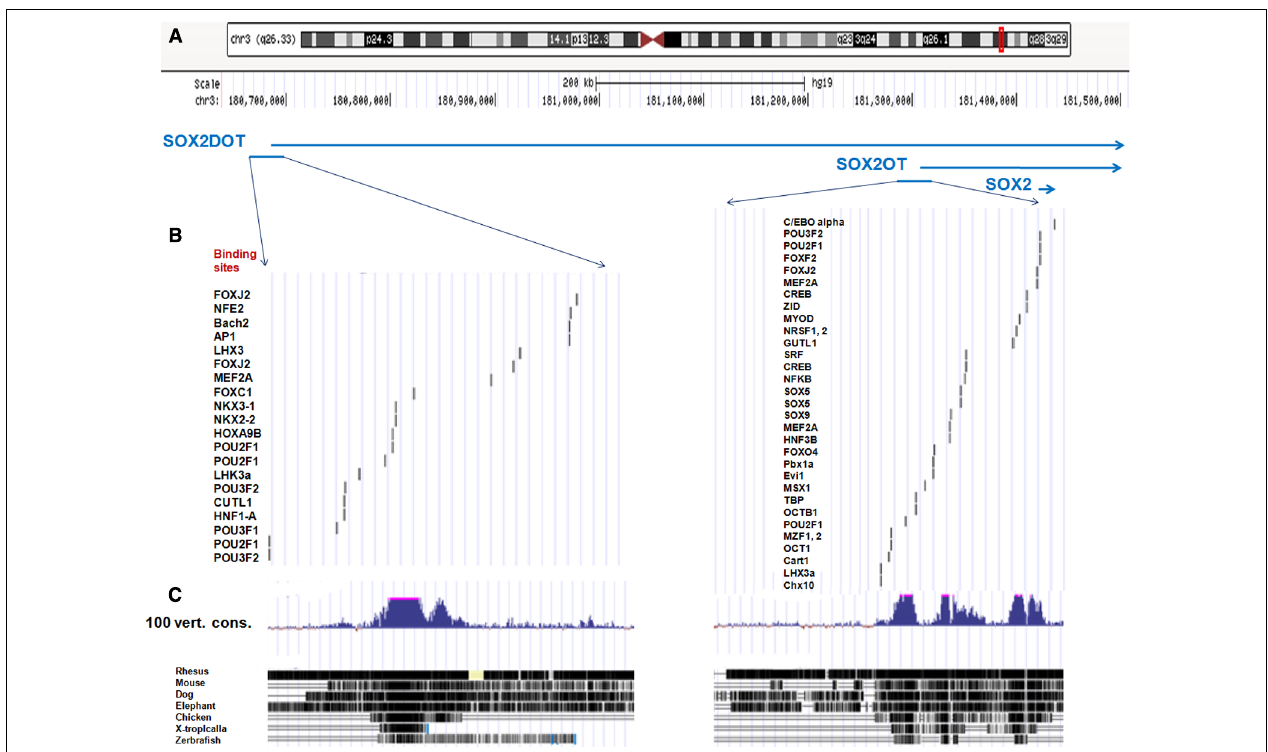
FIGURE 1 | Genomic architecture of Chr3q26.33 region in human and vertebrates. (A) The banding pattern of chromosome 3 and location of SOX2OT locus of 3q26.33 is presented according to the UCSC genome browser (h19 assembly). (B) The conserved transcription factor binding sites is presented at upstream of human genomic regions of SOX2OT and the isoform